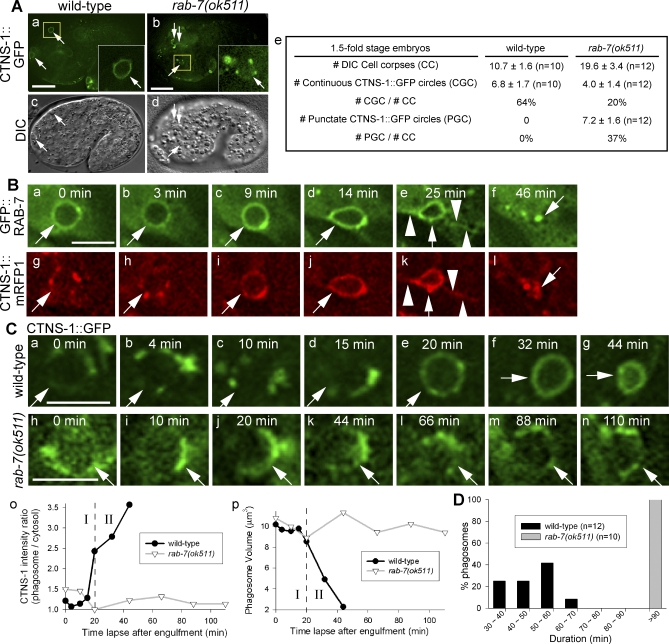

rab-7 Is Required for Both the Recruitment and Fusion of Lysosomes to Phagosomes(A) CTNS-1::GFP around cell corpses in 1.5-fold wild-type and rab-7(ok511) (m−z−) embryos. Insets represent 3-fold enlargement of the boxed regions. (e) The number of DIC(+) cell corpses and CTNS-1::GFP circles around cell corpses in 1.5-fold embryos are presented as mean ± SD. n, number of animals scored. Scale bars represent 10 μm.(B) Time-lapse images of epifluorescence signals on the C2 phagosome (arrows) in a wild-type embryo coexpressing Pced-1 ctns-1::mrfp1 and Pced-1 gfp::rab-7. Scale bar indicates 5 μm. “0 min” represents when GFP::RAB-7 is first recruited to C2. Arrowheads indicate tubular structures extended from phagosomes.(C) Time-lapse images of CTNS-1::GFP signal on the C1 phagosome (arrows) in wild-type and rab-7(ok511) (m−z−) embryos. “0 min” represents when the nascent C1 phagosome is formed. Scale bars indicate 5 μm. (o) and (p) Quantitative data measured from images (a–n), including CTNS-1::GFP intensity ratio (phagosome/cytosol) and phagosome volume, are plotted over time. The two phases of CTNS-1 localization pattern are labeled as I and II.(D) Histogram indicating the distribution of the durations of phagosomes in wild-type and rab-7(ok511) (m−z−) embryos measured using CTNS-1::GFP as a reporter. n, number of phagosomes scored.